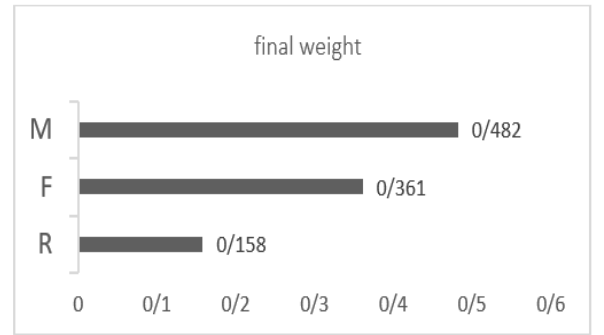
Fig. 2. Final weight of each RFM model variables.